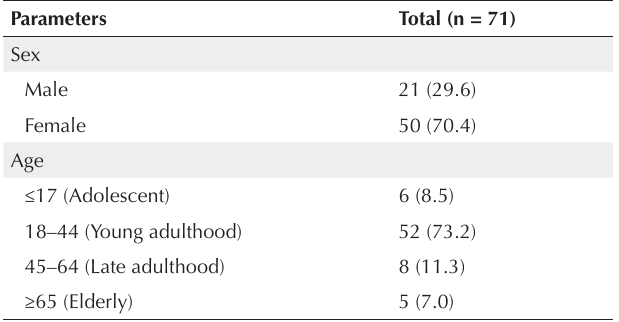
Table 1. Demographic Profile of Travelers With Diarrhea at Kasih